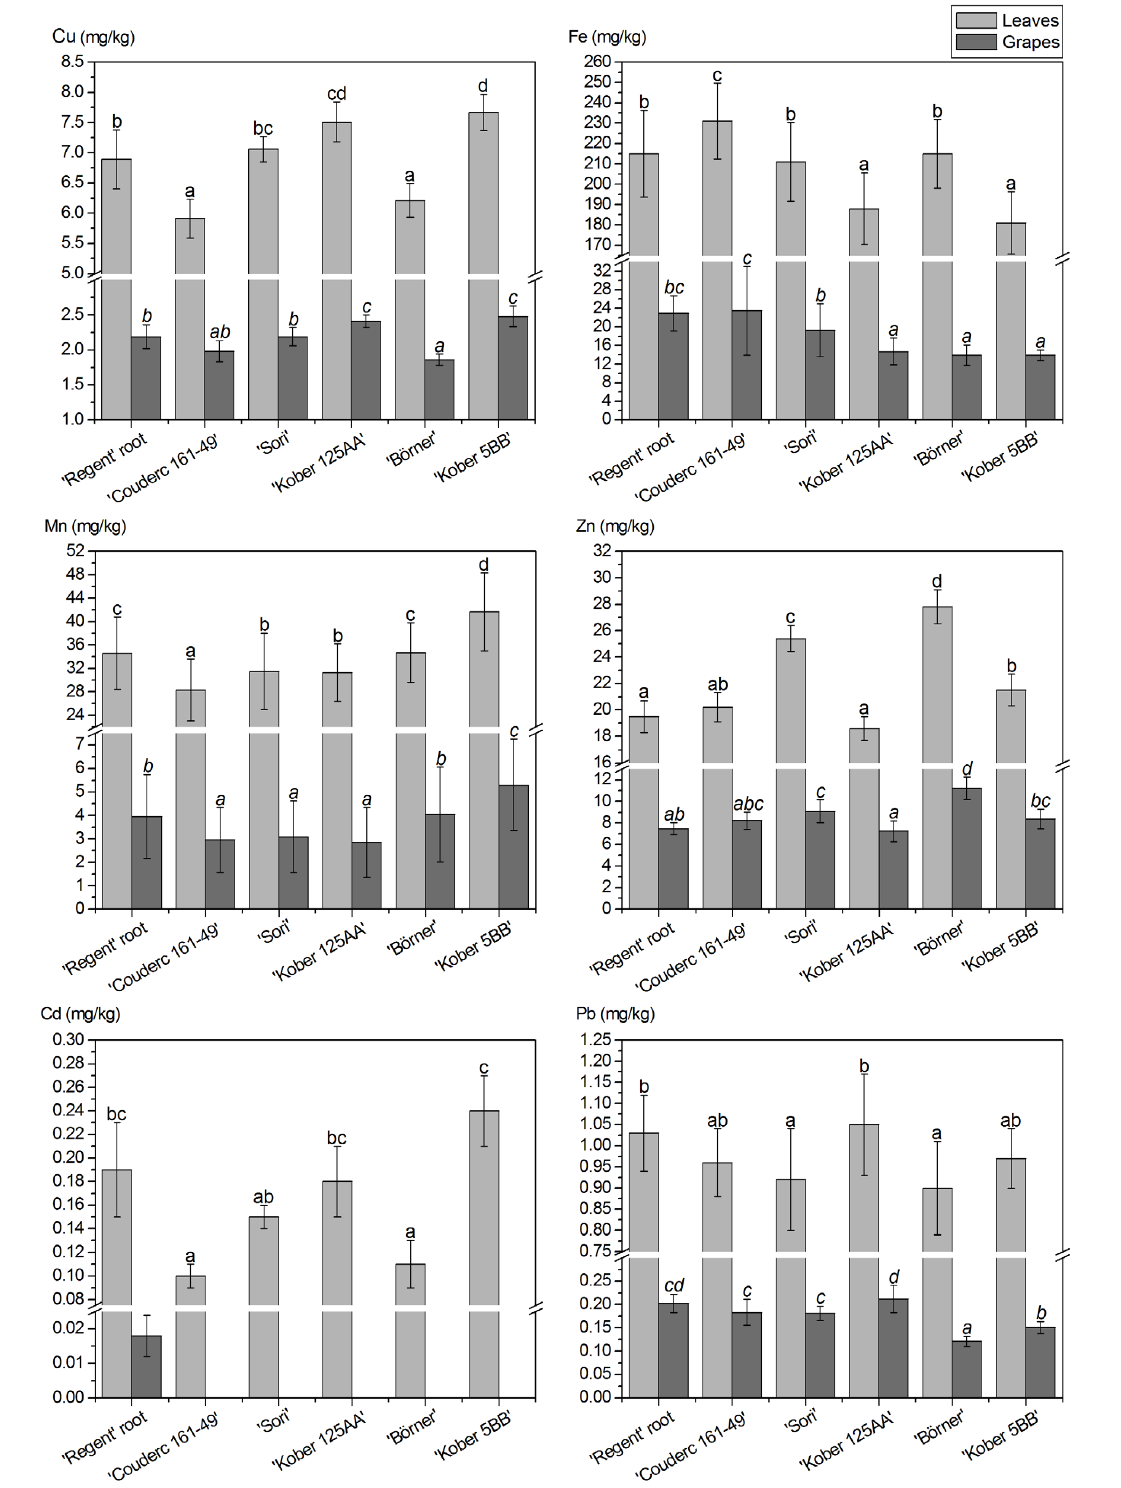
Fig. 2: The average of micronutrient content and heavy metals (mg/kg) in leaves and berries of the ‘Regent’ cultivar from the own-rooted and grafted vines during three years of study (2013-2015). Means having same letter were not significantly different by Tukey’s comparison at p < 0.05 level. Lowercase letters (a) indicate the means of leaves, and italic letters ( a ) of berries. Plant materials obtained from own-rooted vines and ‘Kober 125AA’ samples of ‘Börner’ (leaves 27.8 mg/kg, berries 11.24 mg/kg), which were characterised by statistically similar uptake of Zn and Pb, with was also marked by one of the lowest accumulation of Cu and Pb in the lowest concentration of zinc and the highest of lead among test- all plant samples, Fe in berries, and Cd in leaves. In case of Fe and ed samples. In contradiction, the highest level of Zn was found in Mn, three of the studied rootstocks diminished nutrients